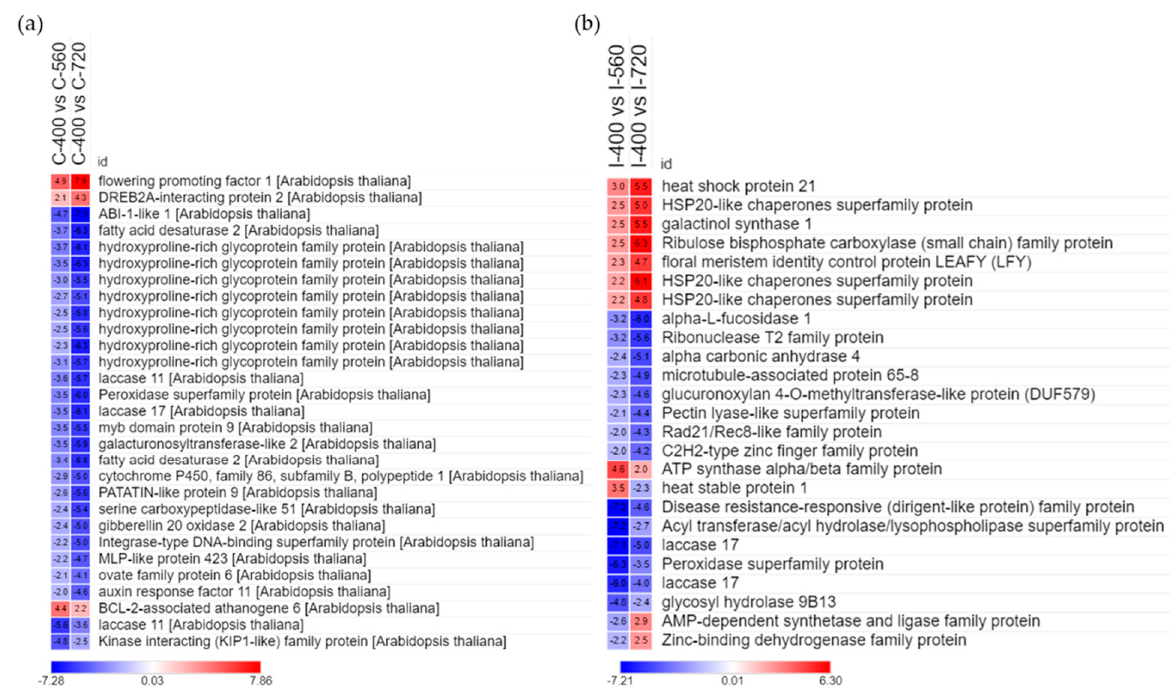
Figure 5. Heat map showing the gene expression pattern of common DEGs in ( a ) Clivus and ( b ) I-476. Corresponding log2 fold change is displayed inside the box. Each species was treated with three different concentrations of CO 2 . C-400, Clivus CO 2 400 ppm; C-560, Clivus CO 2 560 ppm; C-720, Clivus CO 2 720 ppm; I-400, I-476 CO 2 400 ppm; I-560, I-476 CO 2 560 ppm; I-720, I-476 CO 2 720 ppm.